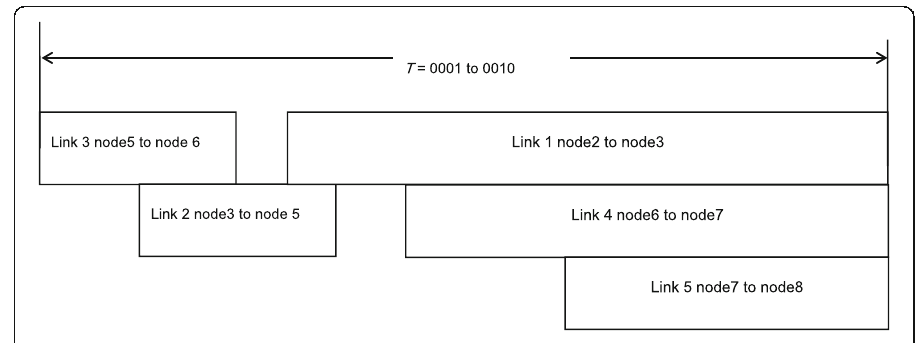
Fig. 9 An example of a link sequence that leads to an invalid